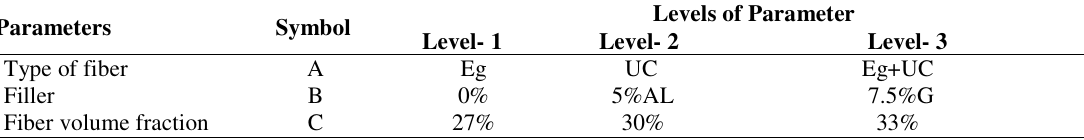
Parameters with their